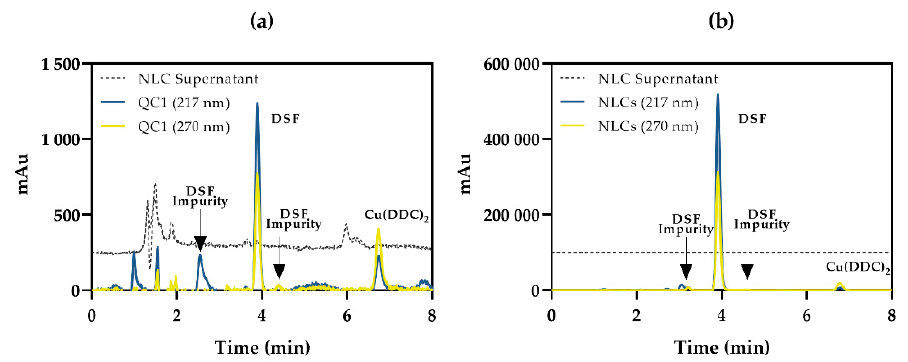
Figure 10. Representative chromatogram of ( a ) QC1 (0.2 µg/mL) solution of DSF and Cu(DDC) 2 (solid lines) and supernatant from blank NLCs (dashed line) and of ( b ) loaded (solid lines) and blank NLCs supernatant (dashed line).